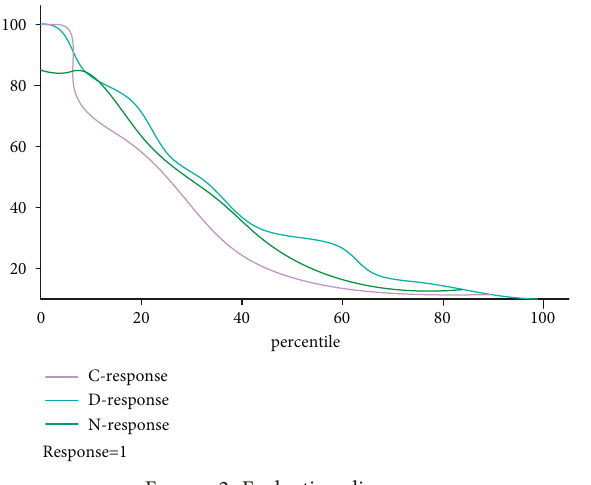
Figure 2: Evaluation diagram. Figure 3: Typical customer lifecycle.